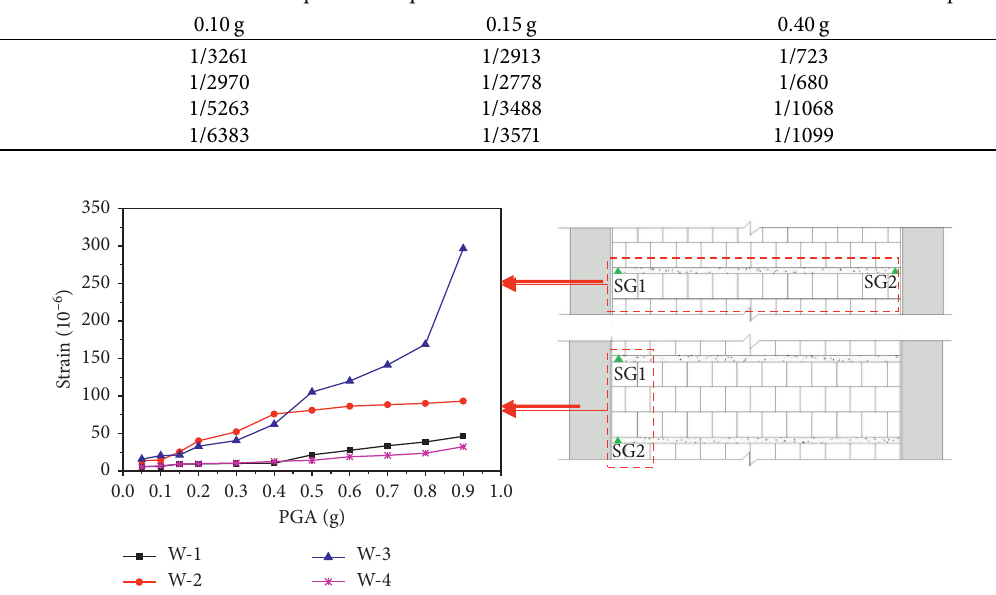
Figure 12: Strain of steel bar in the cast-in-place